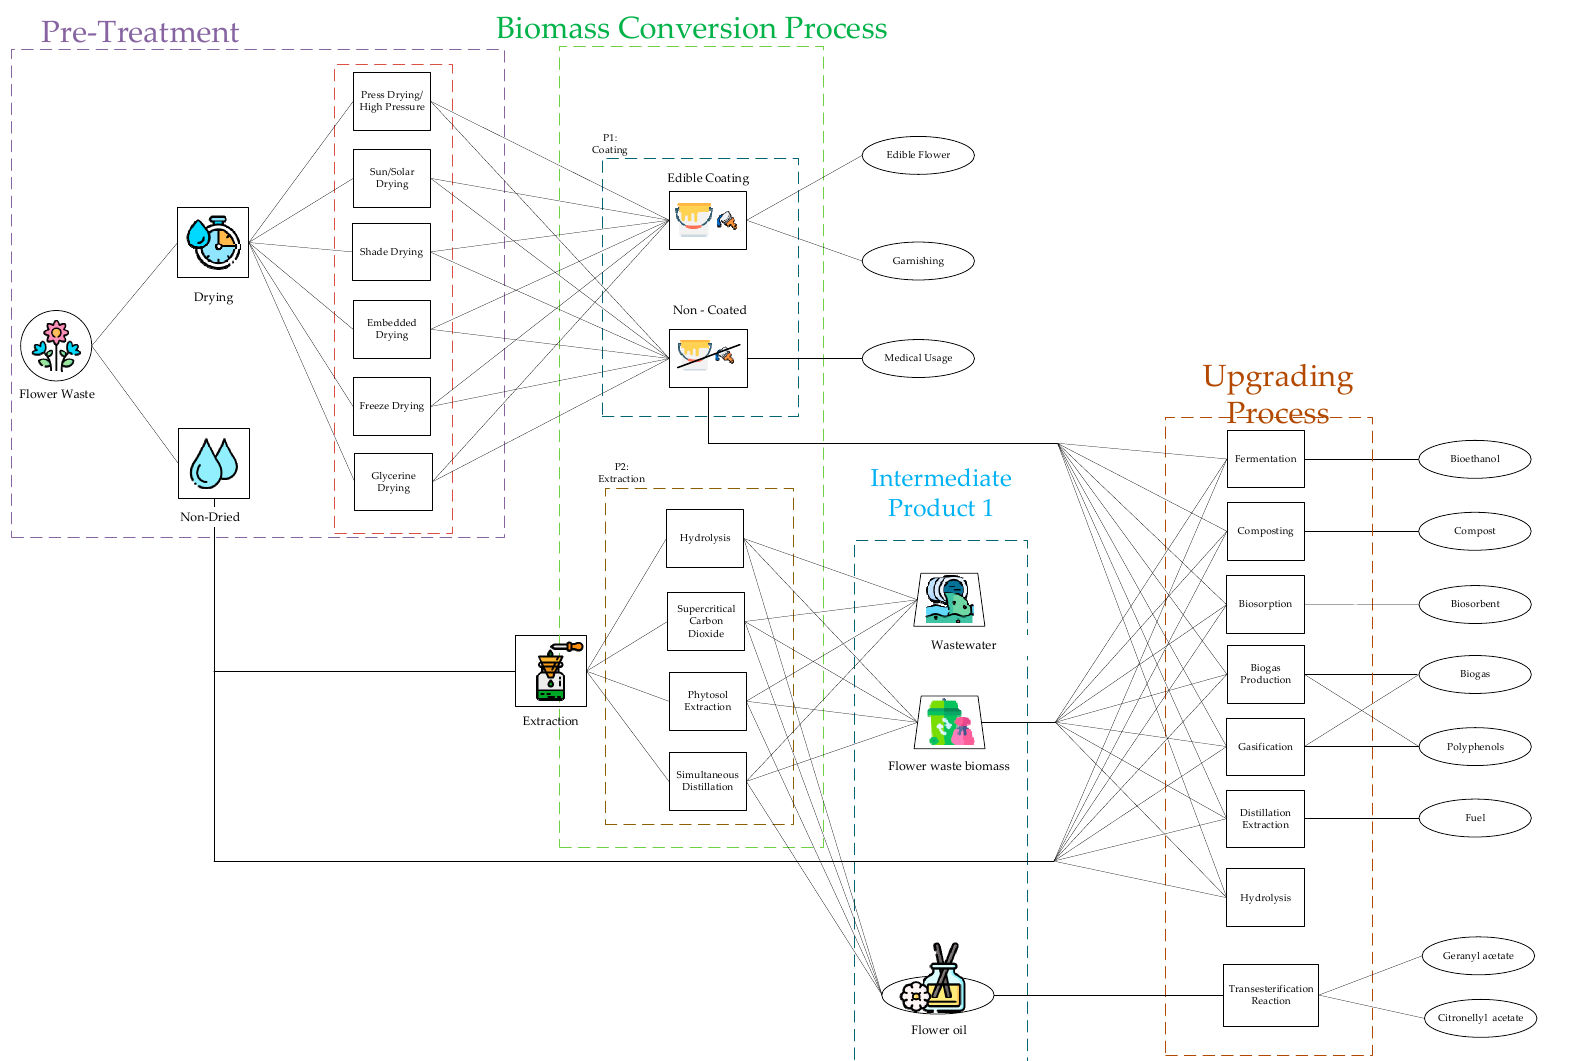
Figure 2. Overall superstructure for synthesis of integrated flower.